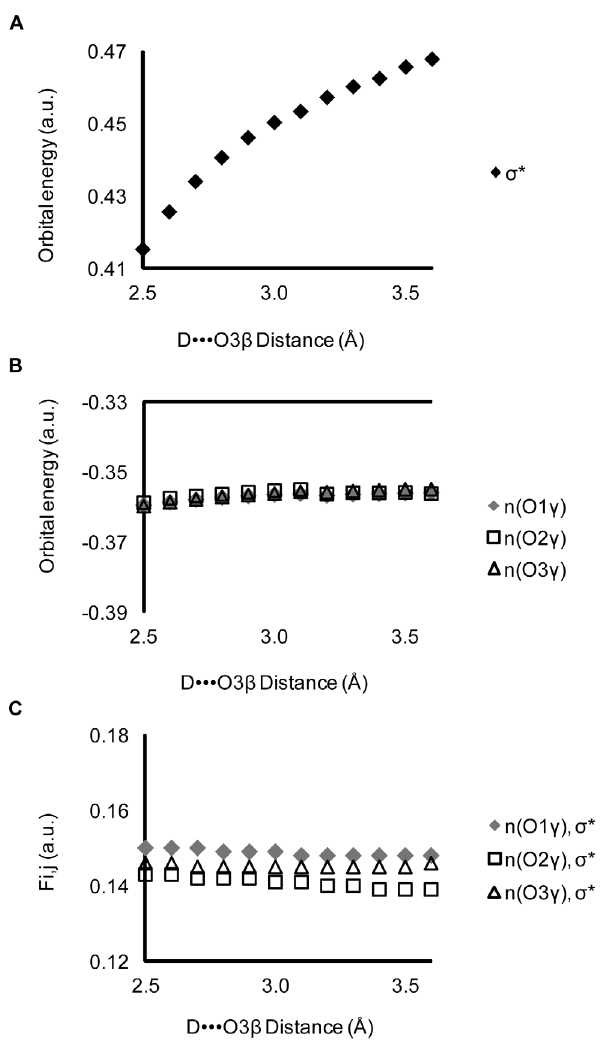
Figure 7. Effects of a hydrogen bond at O 3 b on orbital and interaction energies in Structure1. Shortening the hydrogen bond between N-methylacetamide and methyl triphosphate: A) decreases the orbital energy of the s *(O 3 b —P c ) anti-bonding orbital; while (B) leaving unchanged both the n(O c ) donor orbital energies and (C) F i,j , a measure of the overlap between the n(O c ) lone pair orbitals and s *(O 3 b —P c ). D denotes hydrogen bond donor. s * denotes s *(O 3 b —P c ).